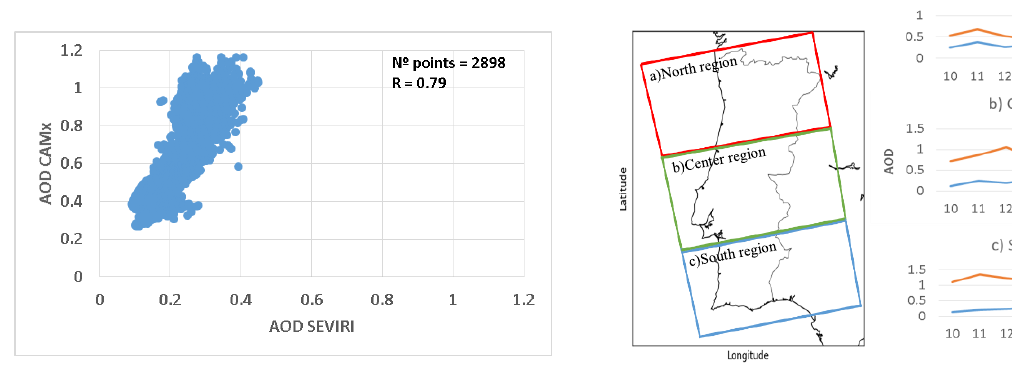
Figure 10. Scatterplot of mean AOD spatial distribution between CAMx and SEVIRI for 10th -17th of May 2011. CAMx results of mean AOD for 10th -17th of May 2011 were evaluated against SEVIRI observations with standard statistical